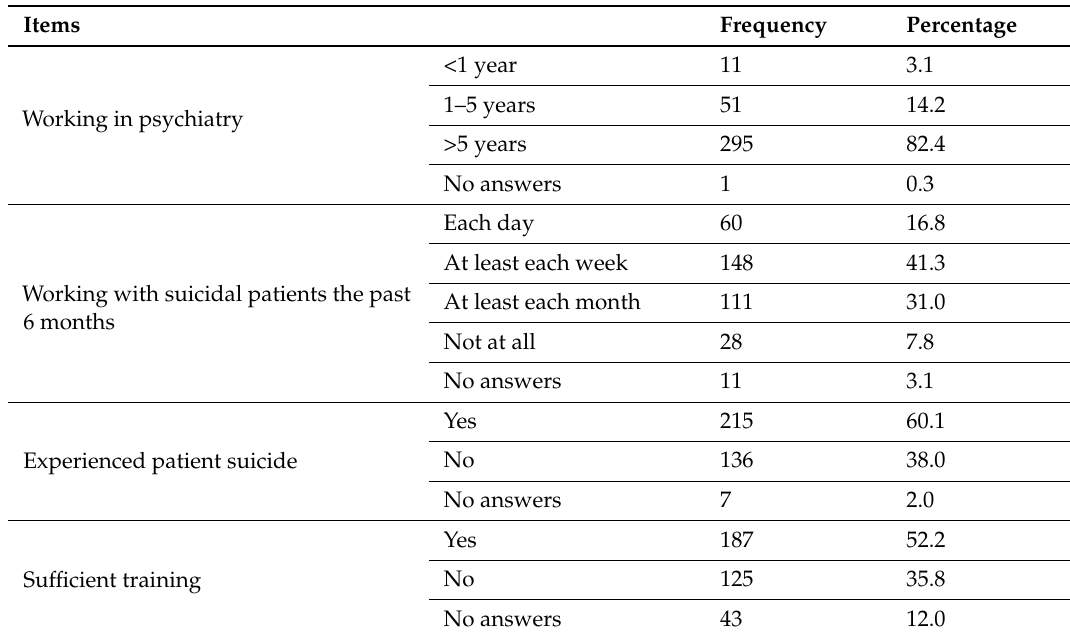
Table 2. Work experience and the perception of being sufficiently trained, total number and percentages, n = 358.